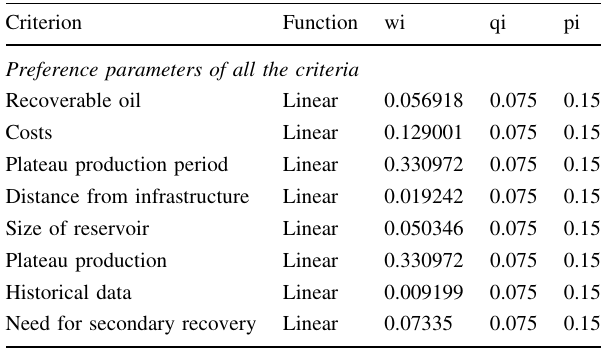
Table 7 PROMETHEE—criteria indifference and preference